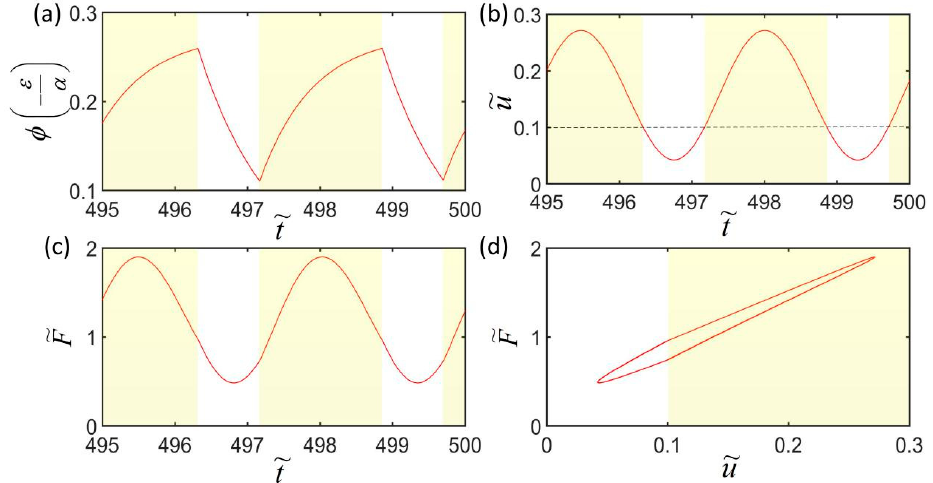
Figure 5. Mechanism of self-excited oscillation of the LCE spring oscillator. ( a ) The change in the cis number fraction of LCE fiber with time; ( b ) the photo-triggered contraction strain of LCE fiber over time; ( c ) the dependence of the driving force on time; ( d ) the relationship between the driving force and the displacement. The parameters are set as (cid:101) I = 0.38, (cid:101) k = 5.8, (cid:101) c = 0.28, α = 0.25, (cid:101) g = 1.2, (cid:101) L p = 1.1, (cid:101) u 0 = 0, and (cid:101)